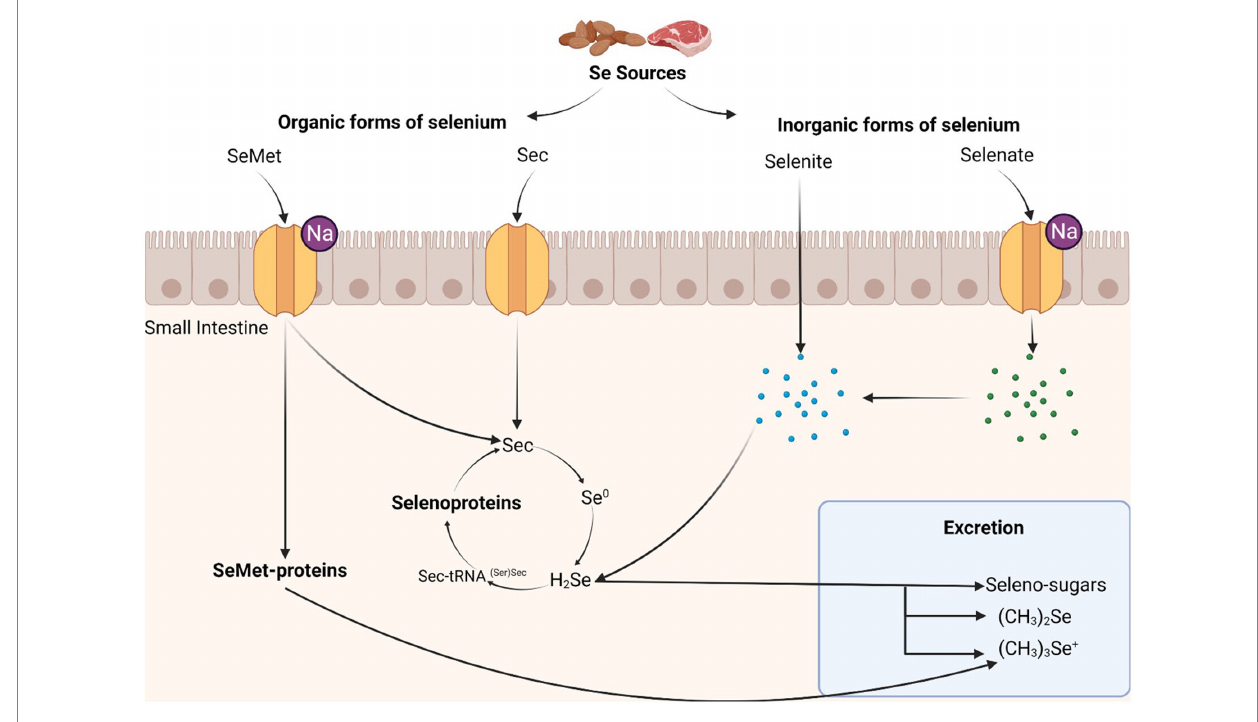
FIGURE 1 Metabolism of selenium in the human body. High sources of selenium include most red meats and some forms of nuts. Selenomethionine (SeMet) is transported across the brush-border membrane of the small intestine through sodium-mediated channels, while selenocysteine (Sec) is transported using mechanisms similar to cysteine. Organic forms of selenium are translated into selenomethionine or selenocysteine-containing proteins. Selenite is transported across the brush-border membrane by passive diffusion, while selenate uses a sodium-mediated channel. Inorganic forms of selenium are either incorporated into selenoproteins or excreted. Selenite, unlike other forms of selenium, is transported through passive diffusion, though this is much slower than transport of other selenium forms. Selenate is converted into selenite before entering the selenoprotein synthesis